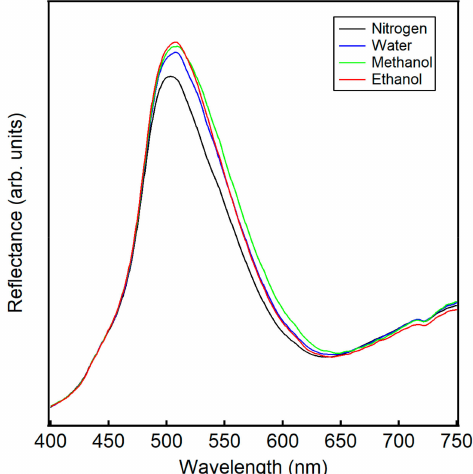
Figure 2. Raw reflectance data from incident light normal to wing scales of the Morpho didius in the presence of nitrogen ( − ), 0.50 P 0 ethanol ( − ), 0.50 P 0 methanol ( − ), and 0.50 P 0 water ( − ). Note the shift in the reflectance peak upon the introduction of analyte vapor relative to